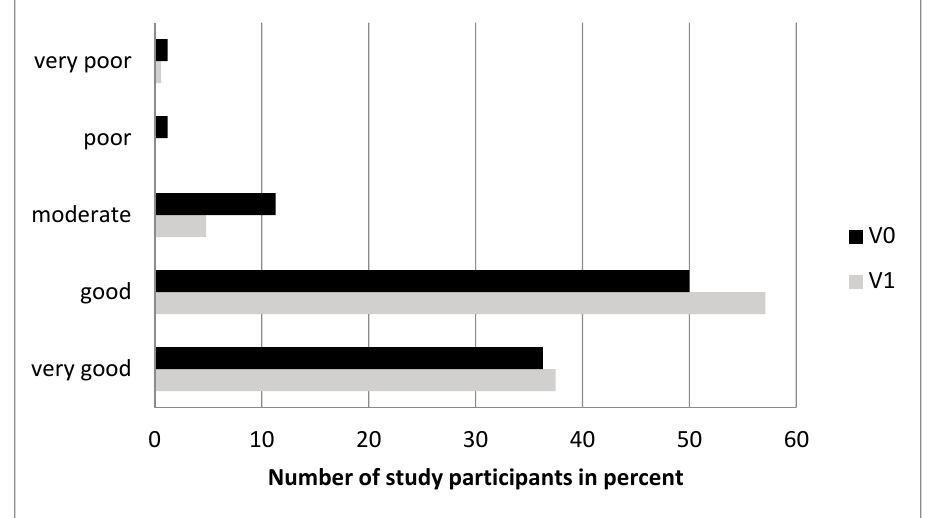
Figure 6. Bar diagram indicating the percentage of study participants (x-axis) rating the quality of their life between very poor and very good (y-axis) before (V0, dark bars) and after iron therapy (V1, bright bars). (no statstically significant differences, n = 168).